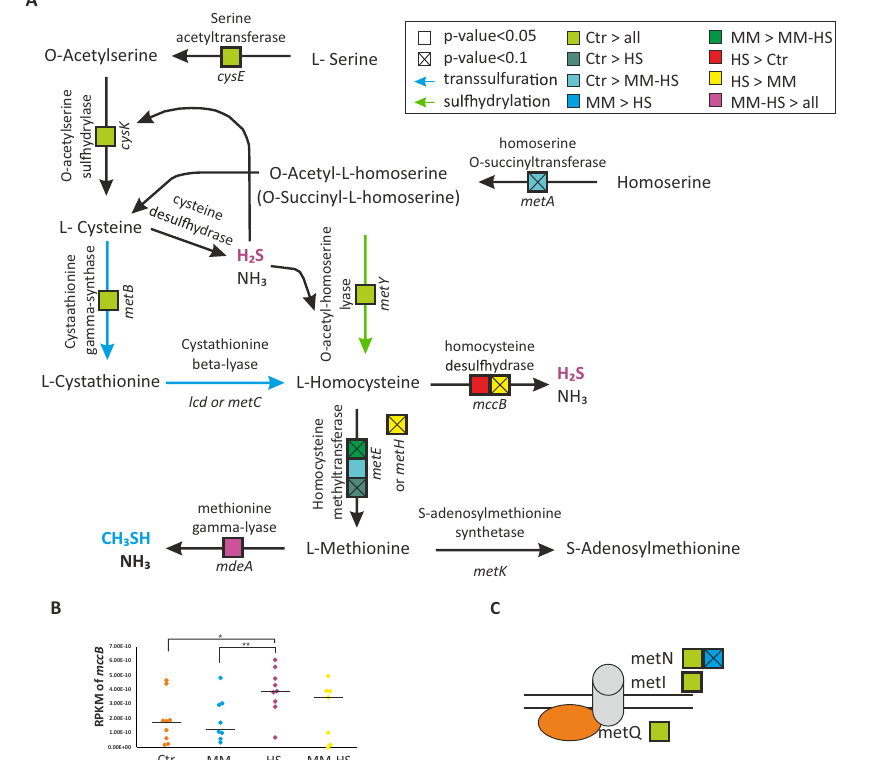
Fig. 6 Gene expression pro fi les in the metabolic route involved in VSCs formation. The diagram represents the genes involved in the formation of HS and MM ( A ). The over-expression of a gene in a group is indicated with a coloured box. The expression levels (measured as RPKM) for the gene mccB are indicated for each group ( B ). Differences in the expression of the three subunits of the methionine membrane transporter are also shown ( C ). RPKM: Number of mRNA reads normalized by gene length (Kbp) and by sequence coverage (Mbp). DESeq2 test was used to calculate the p -values.